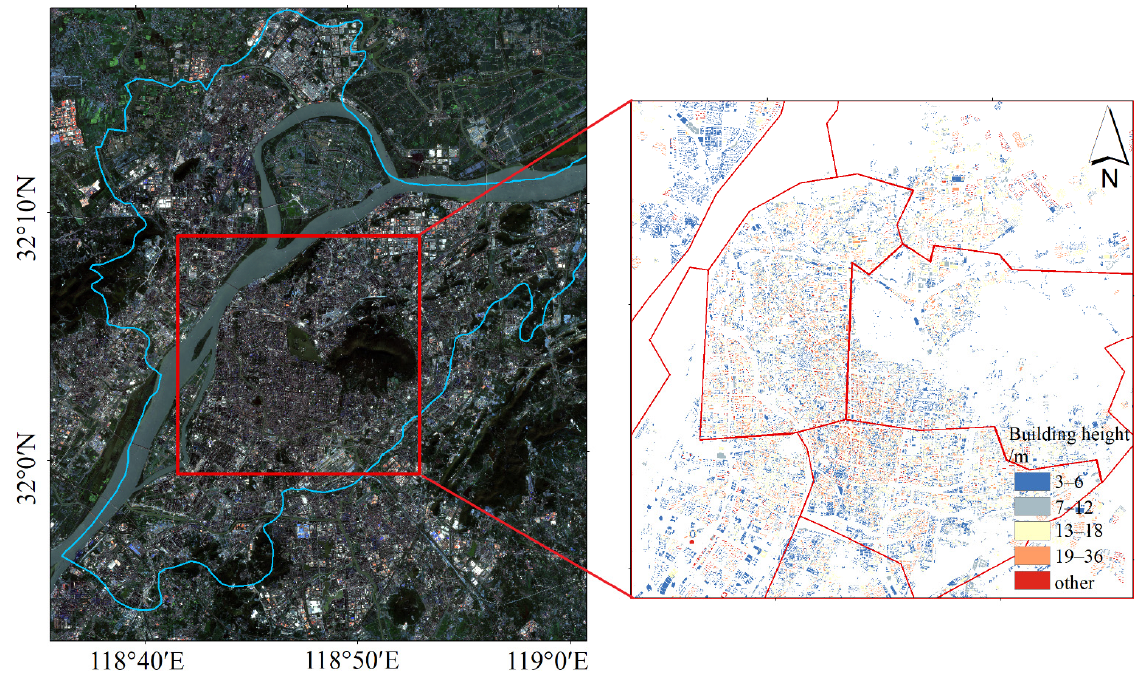
Figure 1. Sentinel-2 true-color composite image and building data of the study area (blue line represents the main urban area of Nanjing; red lines represent the study area boundaries).